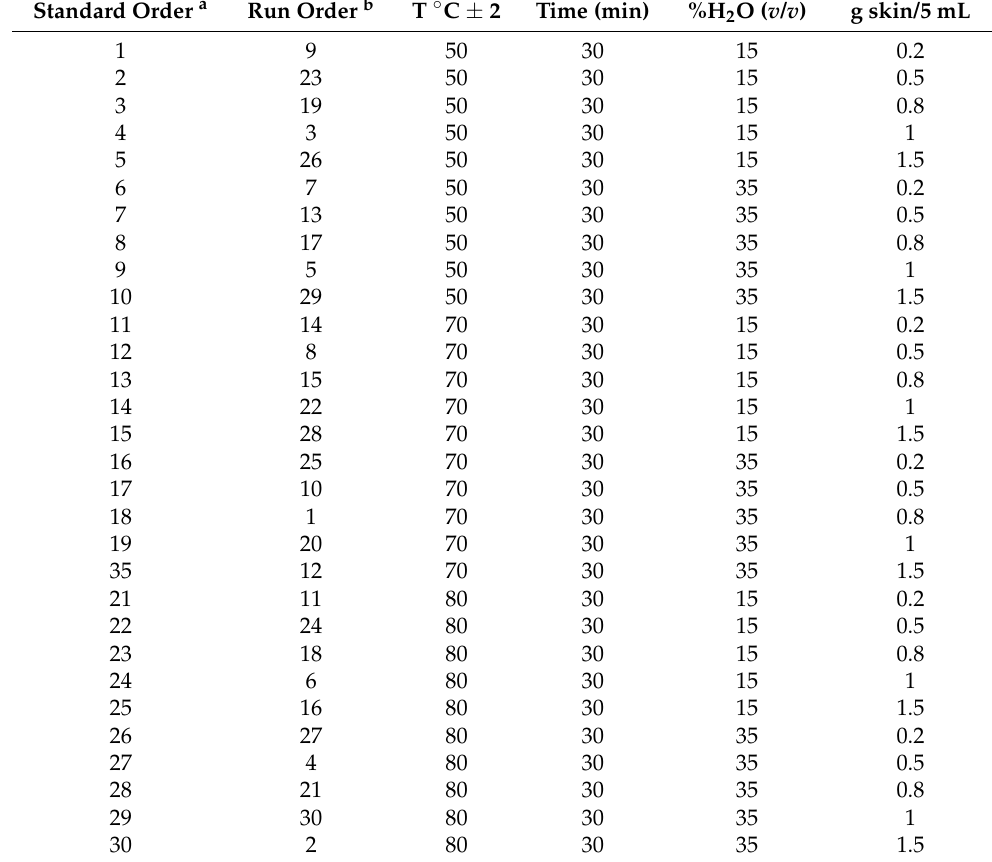
Table 2. Dataset of the experiment.